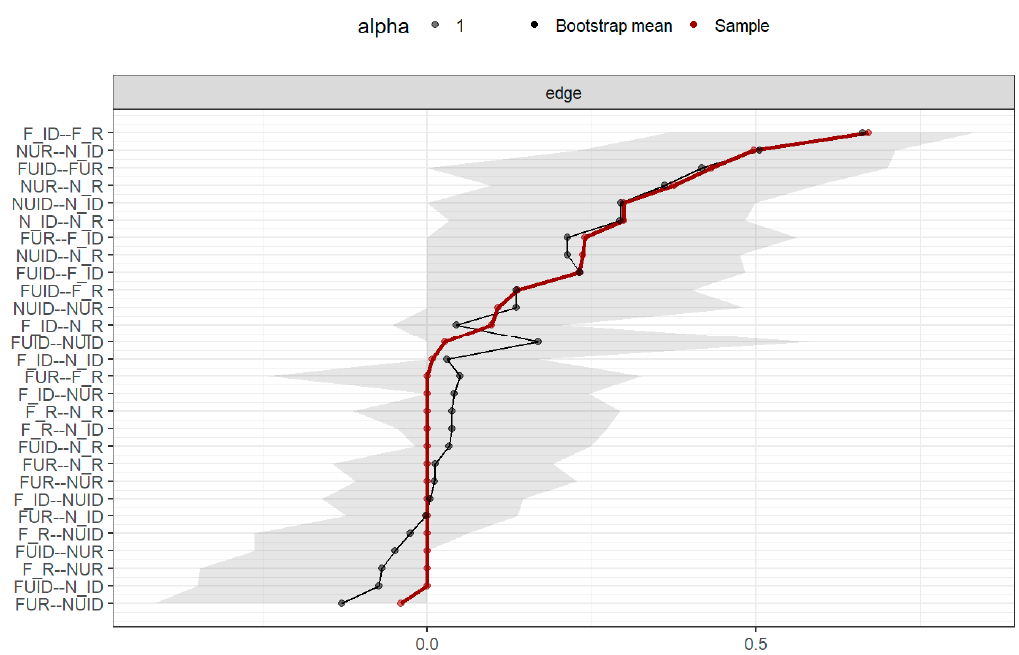
Figure 8. Centrality stability is investigated using subset bootstrapping for the Brazilian subsample.